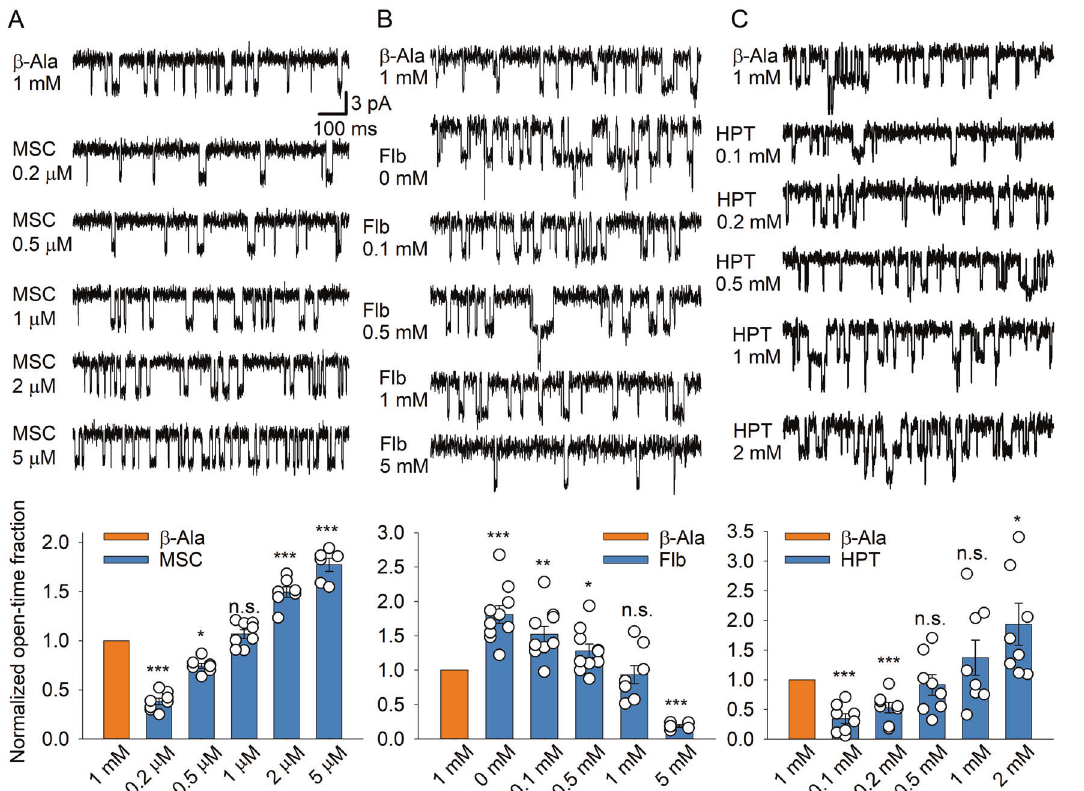
Fig. 3 Single-channel recordings demonstrate the effect of β -Ala on GABA A Rs, NMDARs, and GlyRs, with the concentration-dependent effects of the selective receptor ligands. A Top: recordings of the single-channel GABA A R openings elicited by 1 mM of β -Ala and different concentrations of a selective GABA A R agonist muscimol (MSC) in the same outside-out patch ( n = 8 recordings/6 animals). Bottom: statistical summary of the GABA A R open-time fraction, normalized to the response produced by 1 mM β -Ala. MSC at the concentration of 1 µM produces the equipotent effect as that elicited by β -Ala. B Same as in A, but for the single-channel NMDAR openings activated by 1 mM of β -Ala and different concentrations of Felbamate (Flb). 1 mM Flb was found as the equipotent concentration to β -Ala ( n = 10 patches/cells per paired recordings made from 7 animals). C Same as in A, but for the single-channel GlyR openings activated by β -Ala and different concentrations of hypotaurine (HPT). HPT at the concentrations of 0.5 mM and 1 mM produced the equipotent effect to that of β -Ala ( n = 8 recordings/8 animals). Scale bars and vertical axis label apply to A – C . * P < 0.05, ** p < 0.01, *** p < 0.001, n.s. non-signi fi cant compared to the effect of β -Ala (Student ’ s paired t